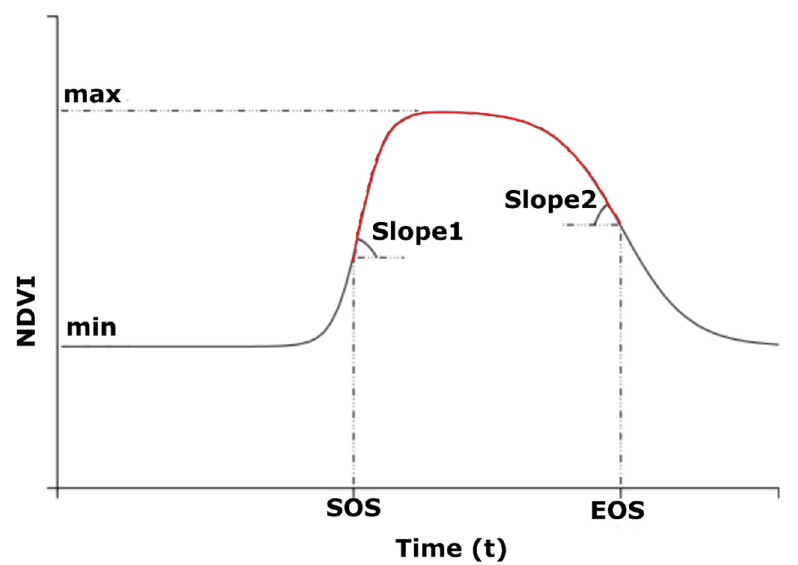
Figure 2. Concept of curve-fitting [27] and identification of SOS and EOS for TNPI computation. The highlighted red area represents the vegetation growth period between SOS and EOS.